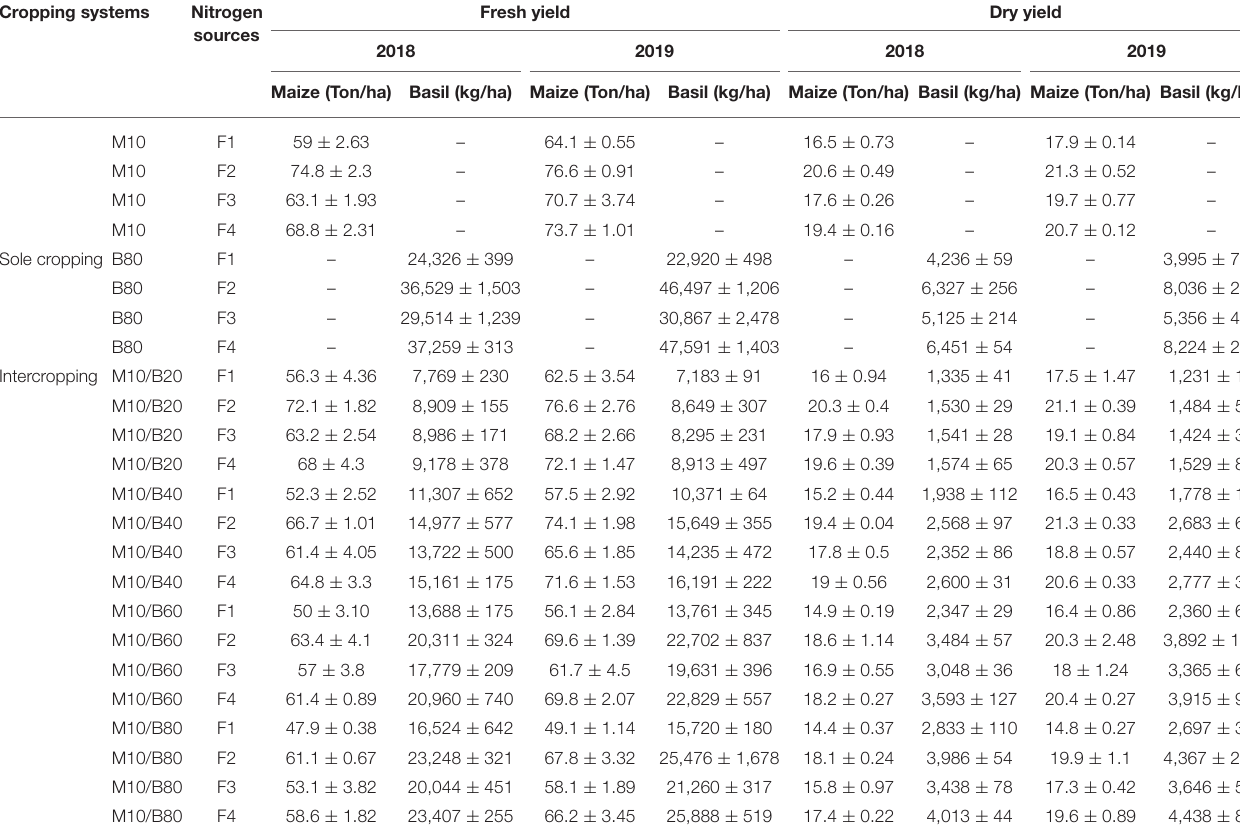
TABLE 3 | Fresh and dry yield of maize and basil as affected by sole and intercropping systems in 2018 and 2019. Cropping